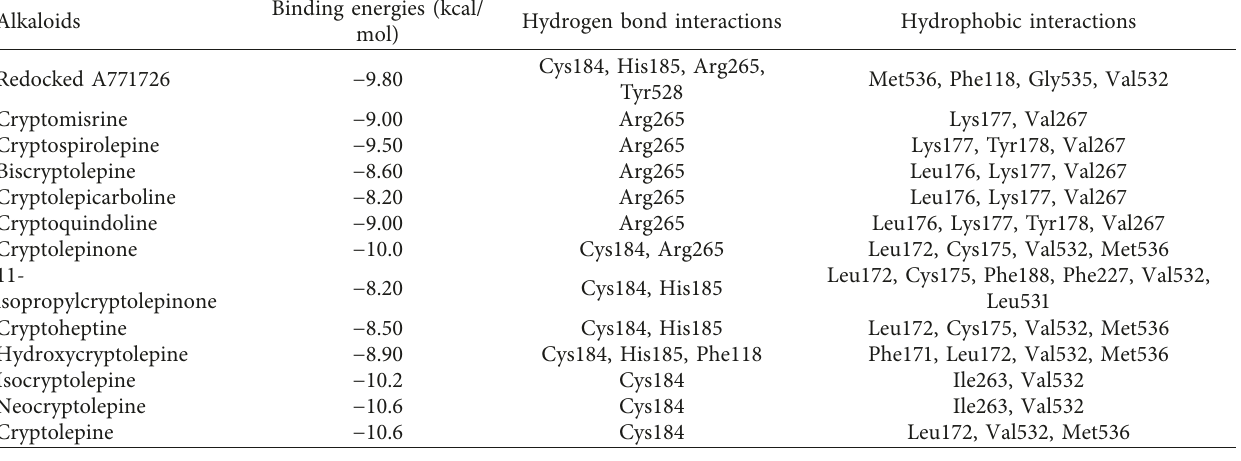
Table 5: Molecular docking result of A771726 and Cryptolepis sanguinolenta alkaloids with Plasmodium falciparum DHODH (1TV5).